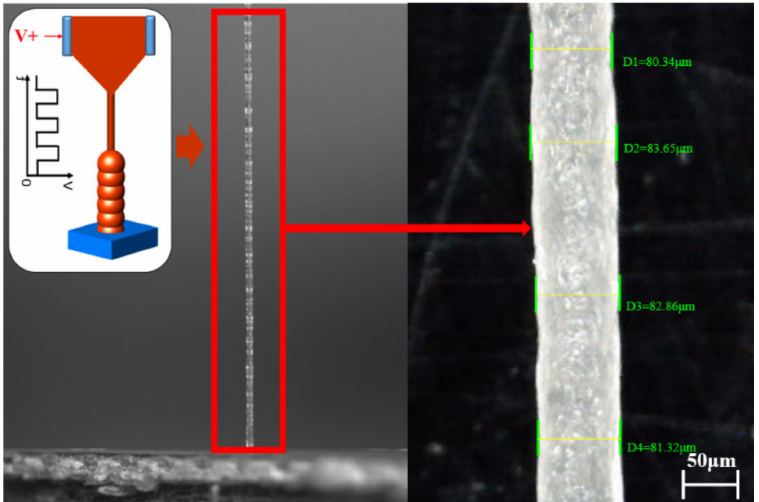
Figure 15. The deposited micro-cylinder of wax droplets with large ratio of height to